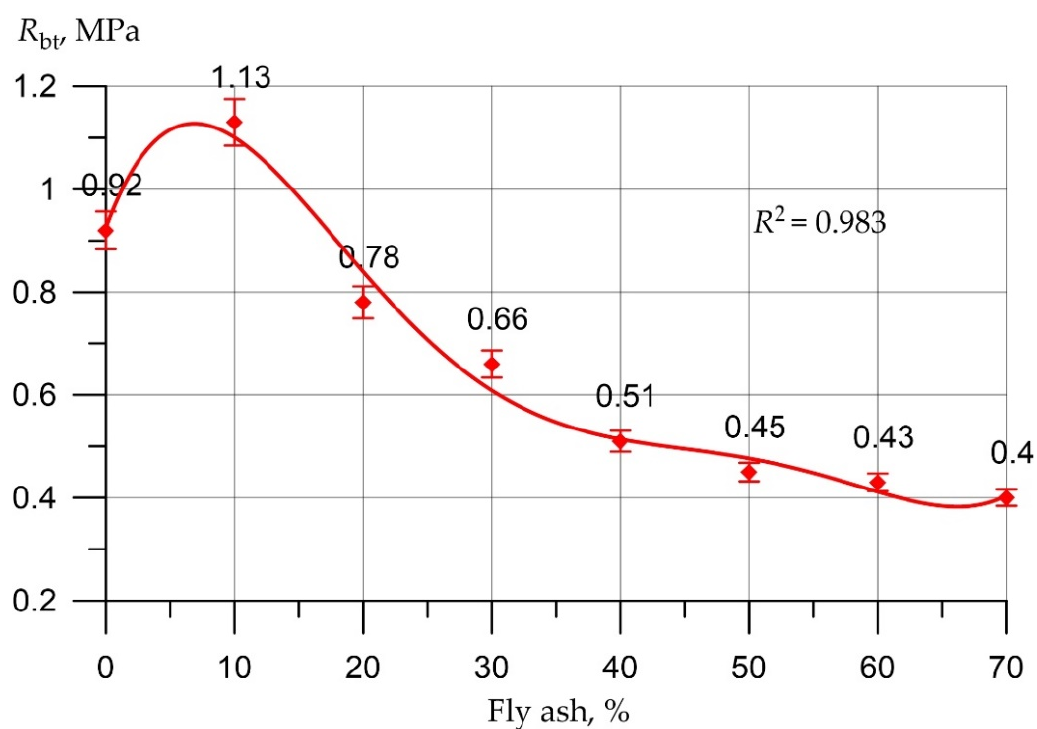
Figure 6. Dependence of the CS of FFC samples on the amount of fly ash introduced instead of cement.